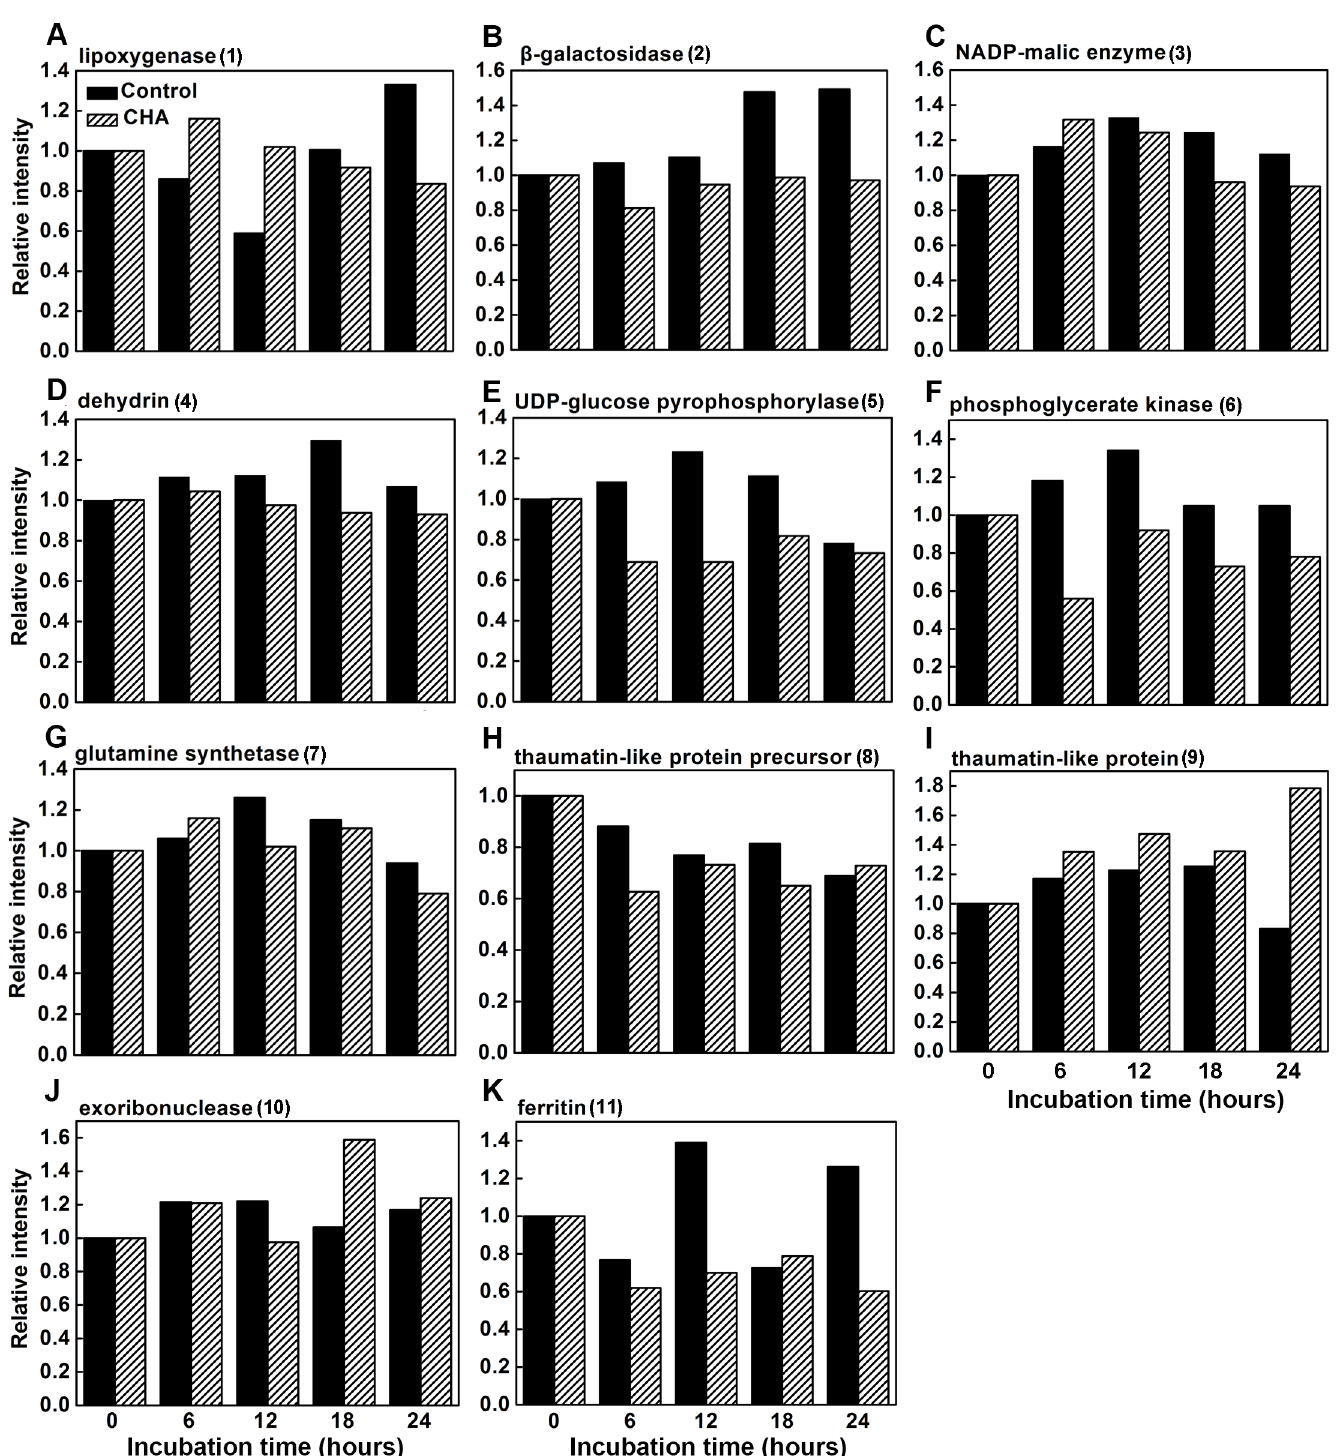
Fig 4. Effect of CHA on changes in levels of the senescence related proteins in apple pulp discs during incubation at 25°C.